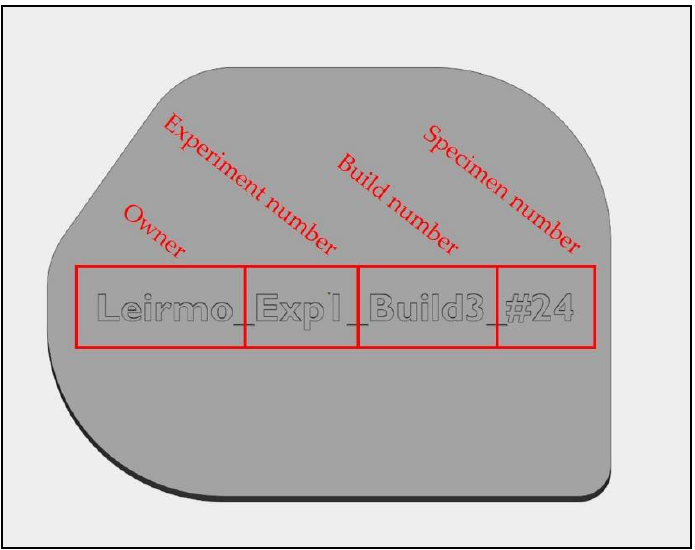
Figure 5. Illustration of the labeling scheme applied in the experiment. The writing is imprinted and embedded in the stereolithography (STL) file during layout preparation in Magics 23.01.